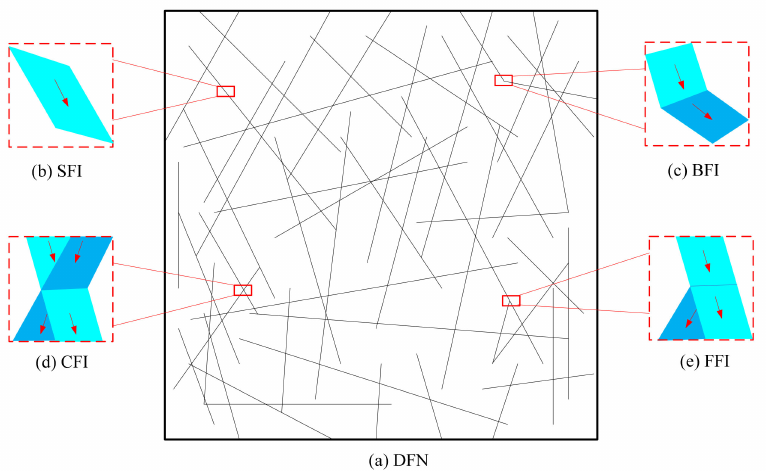
Figure 8. ( a ) A schematic diagram of a discrete fracture network containing different types of fracture intersections: ( b ) Straight fracture intersection (SFI), ( c ) Buckling fracture intersection (BFI), ( d ) Crossing fracture intersection (CFI), and ( e ) Furcating fracture intersection